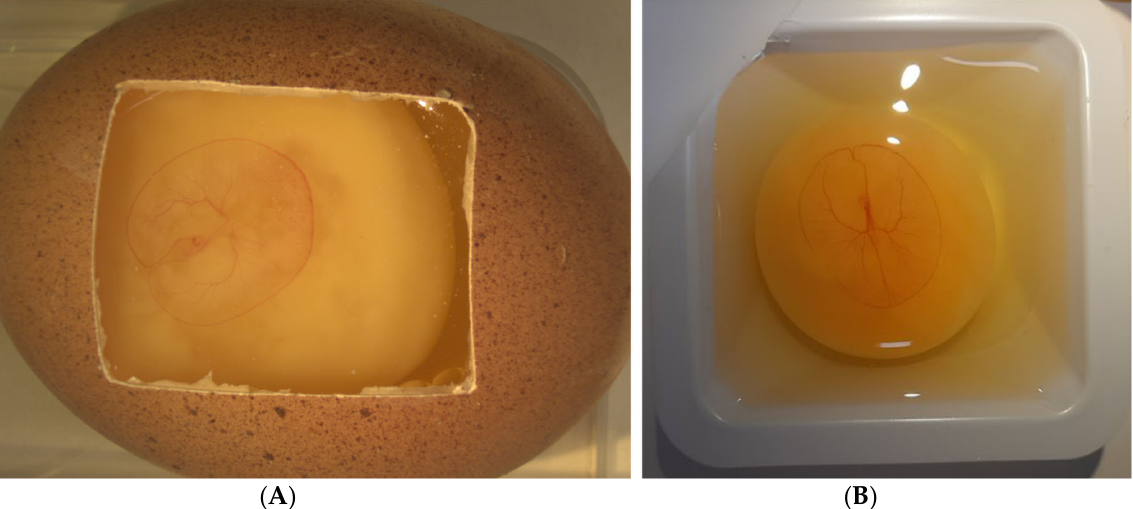
Figure 3. 4 ‐ day old chick embryo and associated chorioallantoic membrane (CAM) following ( A ) In ovo and ( B ) Ex ovo cultivation. The CAM expands as the embryo grows. Ex ovo cultivation is beneficial through the larger surface area available for experimentation, however embryo survival is impacted.